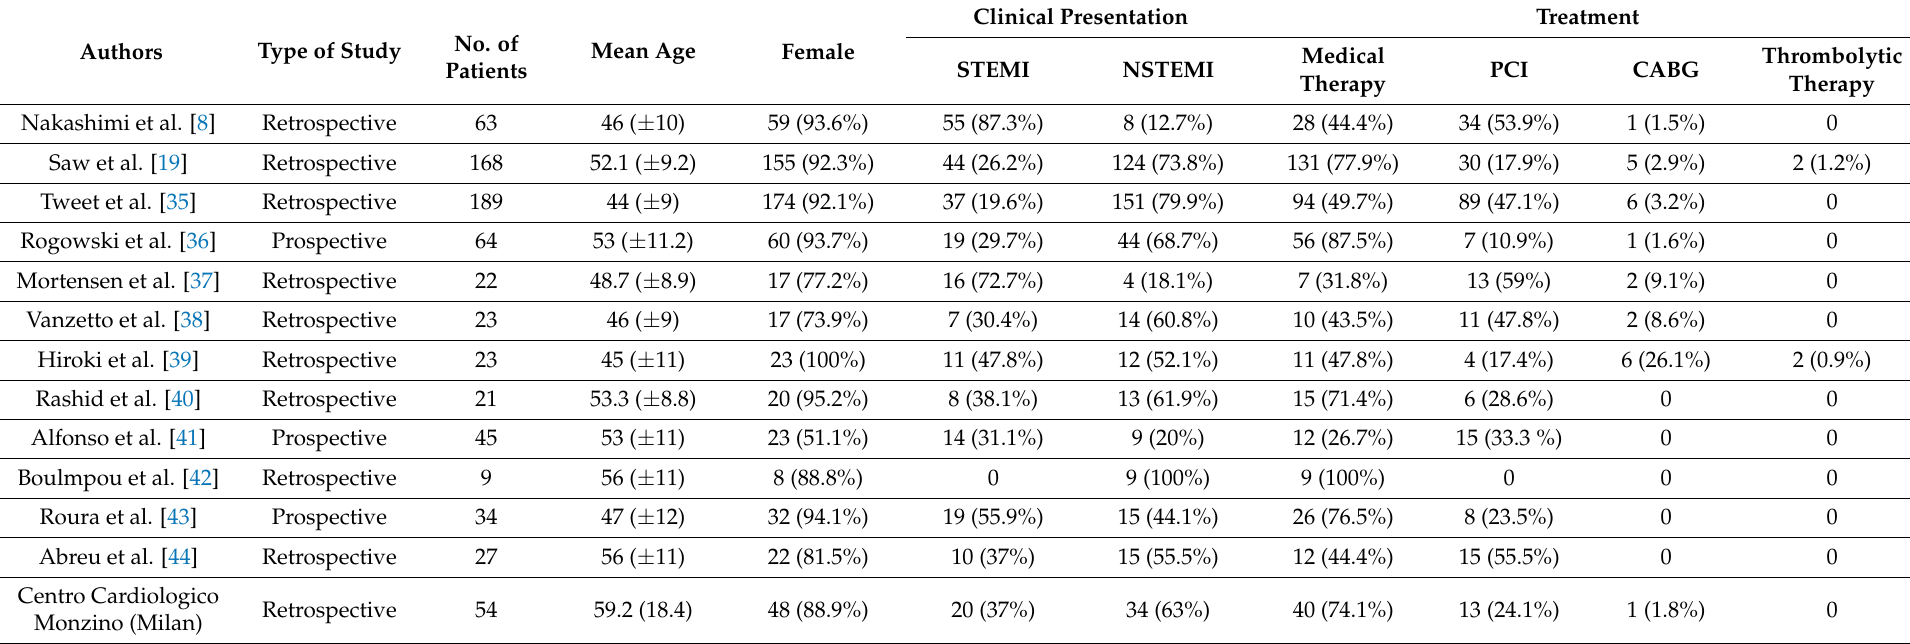
Table 2. Literature case series compared to Monzino’s